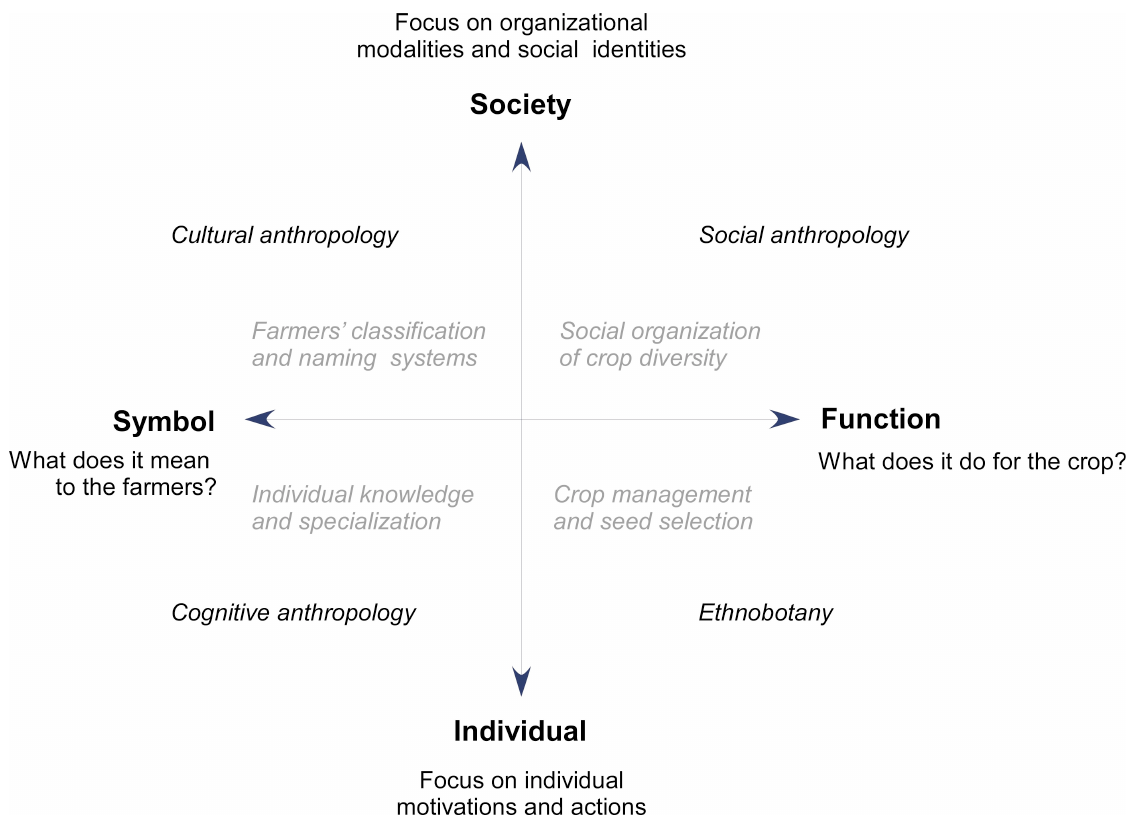
Figure 1. Diagrammatic representation of the main fields of anthropology that study the social factors affecting crop diversity, with examples of specific areas (in grey), according to the focus on functional vs. symbolical analysis, using either individual or social based